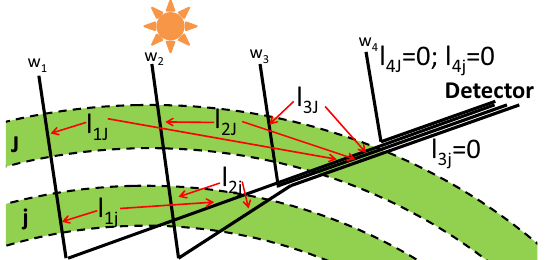
Figure 1. A sketch of light paths (with corresponding weights) crossing two boxes (layers) in limb geometry for the illustration of the variables in Eqs. (5) and (7). w 1 ...w 4 indicate weights of vari- ous paths photons may take travelling from the Sun and reaching the detector. j and J represent two arbitrarily selected boxes (layers); l 1 ... 4 ,j...J are the lengths of individual paths through the boxes. The red arrows indicate that the path is obtained by summation of the two segments through the box. In the case the path is not crossing any box, its length is 0, as